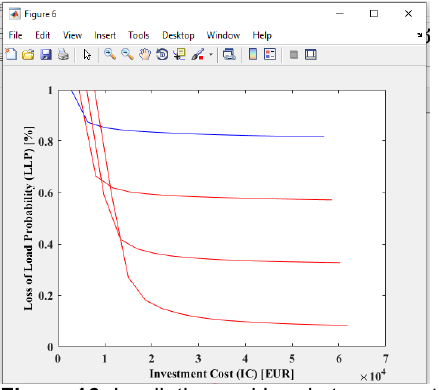
Figure 13. Irradiation and Load at average hours